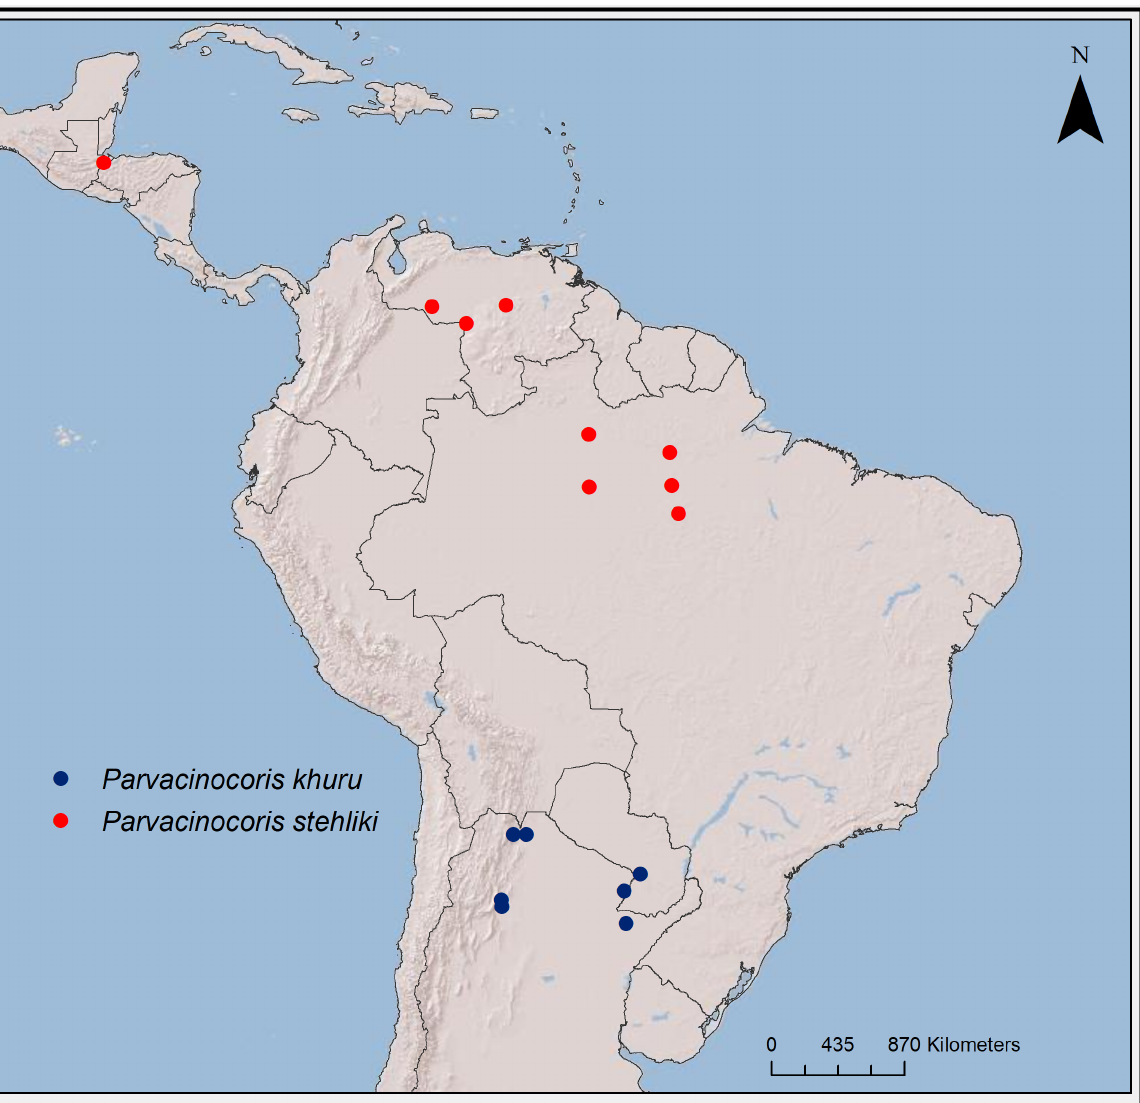
Figure 14 - Distributional map of Parvacinocoris stehliki (Doesburg, 1966), n. comb. and Parvacinocoris khuru , n.